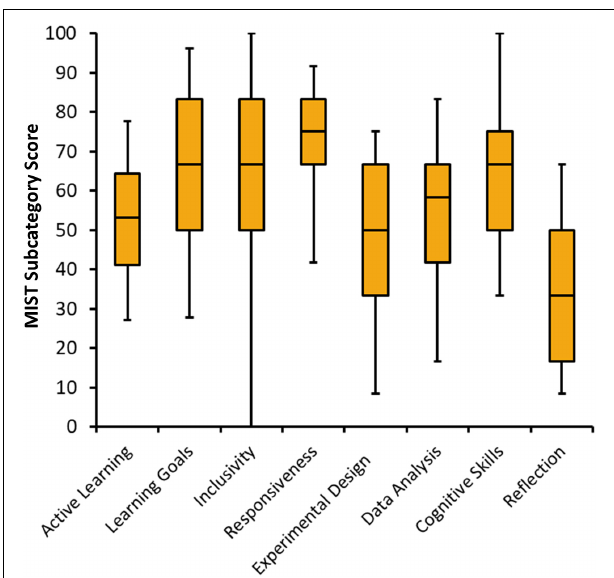
FIGURE 3 | Survey participants’ teaching practices measured by the MIST-Short. Scores align with the eight subcategories of Scientific Teaching practices: Active-Learning Strategies (Active Learning), Learning Goal Use and Feedback (Learning Goals), Inclusivity, Responsiveness to Students (Responsiveness), Experimental Design and Communication (Experimental Design), Data Analysis and Interpretation (Data Analysis), Cognitive Skills, and Course and Self-Reflection (Reflection). Central bars represent median scores, boxes reflect interquartile range, and whiskers represent the 5th and 95th percentile